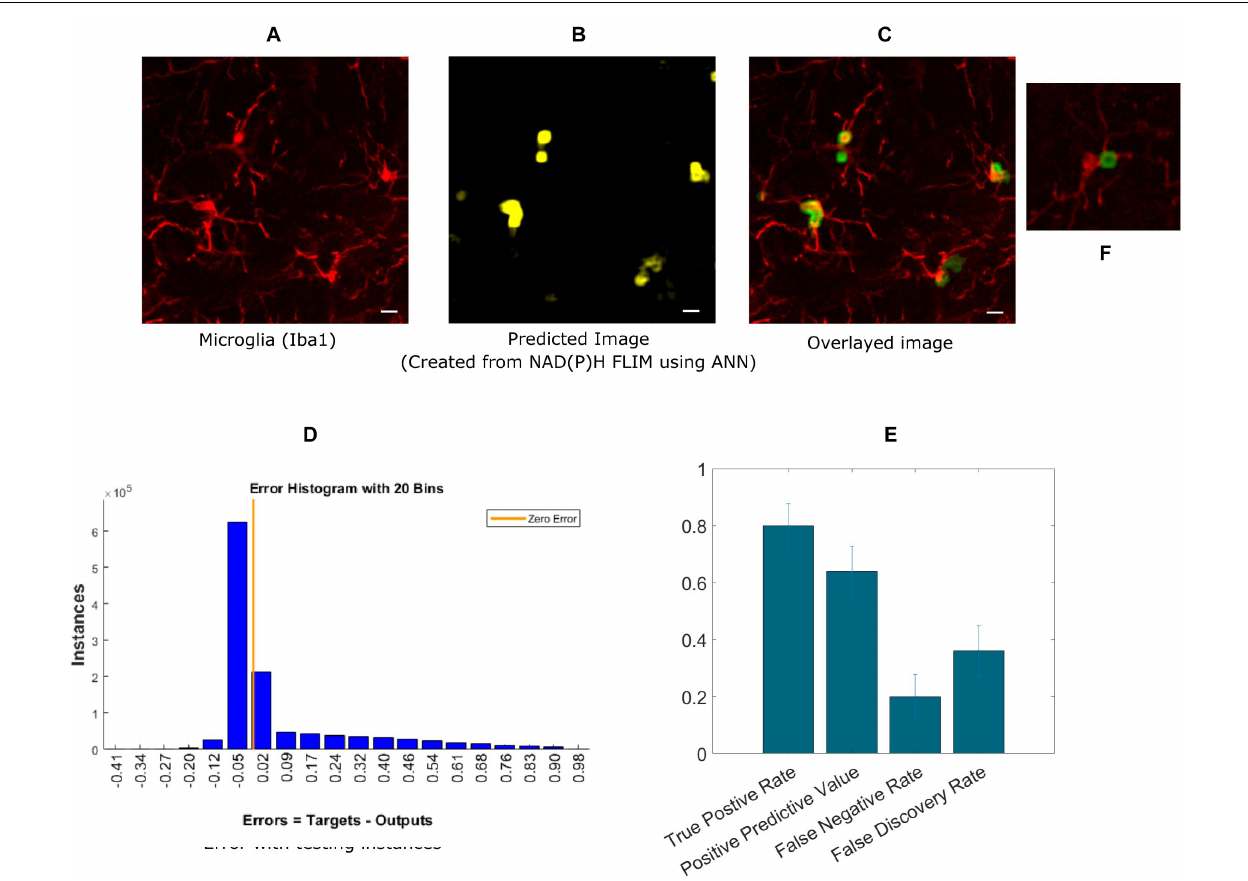
FIGURE 3 | Prediction of microglia from NAD(P)H lifetime data in mouse brain tissue. In this approach, ANN is applied on exported lifetime parameters of the endogenous fluorophore NAD(P)H. (A) Original intensity image of microglia location created from the anti-Iba1 antibody AlexaFluor594 channel (B) Predicted microglia image from NAD(P)H lifetime data from the same field-of-view. Composite image of predicted microglia image and original intensity image. (C) Composite image of predicted microglia image and original intensity image. (D) Error rate from training and (E) TPR, PPV, FNV, and FDR from five different tissues (Scale bar 10 µ m, A–C,E ). (F) Zoomed in image of a microglia where a process is identified as